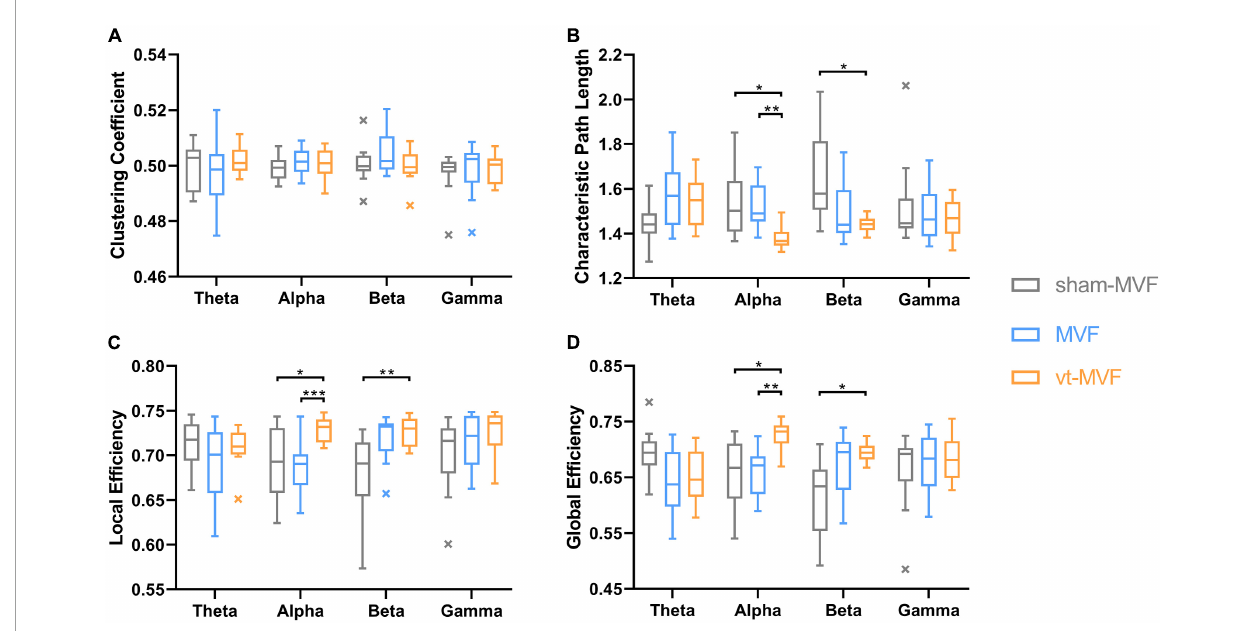
FIGURE5 Network metrics, including (A) clustering coefficient, (B) characteristic path length, (C) local efficiency, and (D) global efficiency, of the three experimental conditions in different frequency bands. The central line in these boxplots indicates the median and the cross markers are the outliers. The asterisk indicates a significant difference between the two conditions (*0.01 < p < 0.05, **0.001 < p < 0.01, *** p < 0.001).